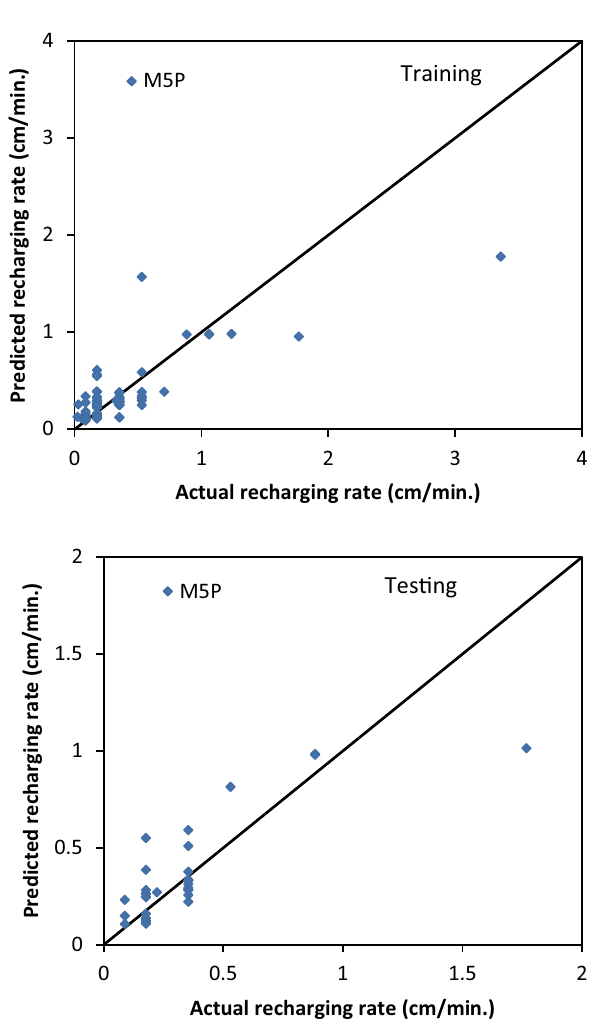
Fig. 3 Performance of M5P tree model